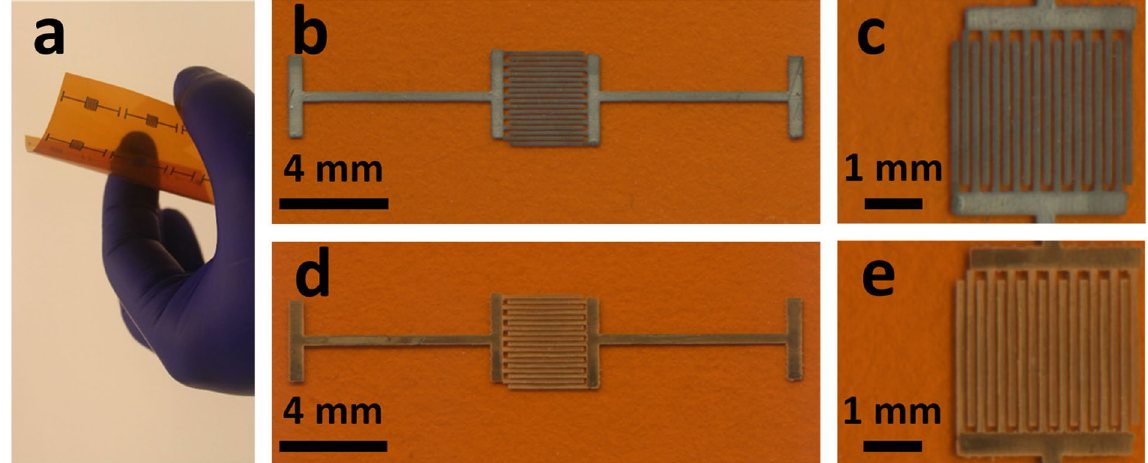
Figure 1. Scanned images of the inkjet-printed sensors before ( a , b and c ) and after ( d and e ) the conversion of the Ag IDEs into their Au counterparts.